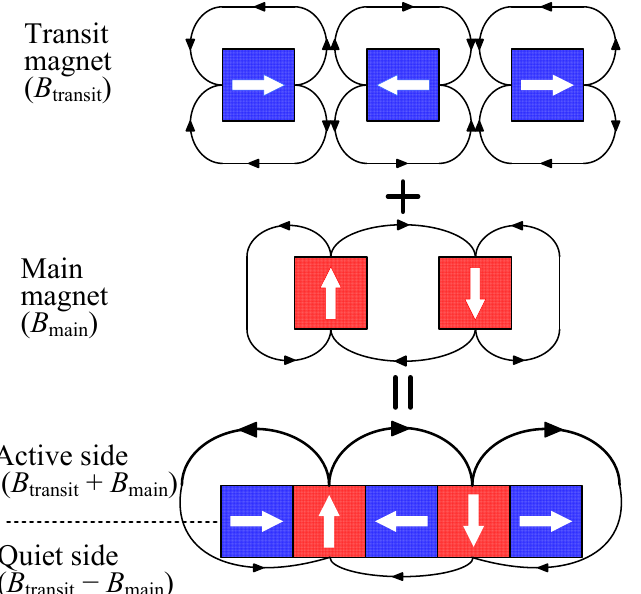
Figure 2. Principle of the Halbach arrays magnetic circuits [20].